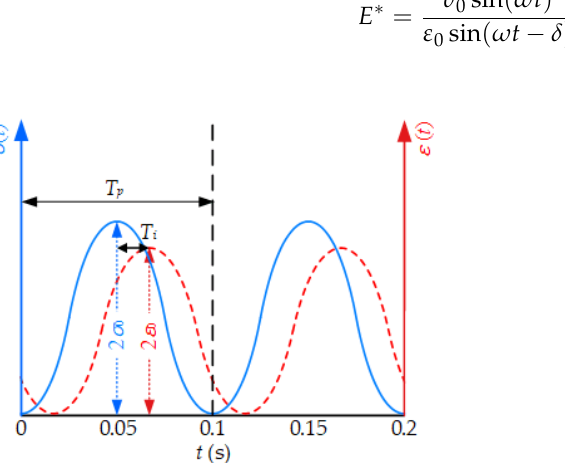
Figure 4. The mechanical response in dynamic modulus test.